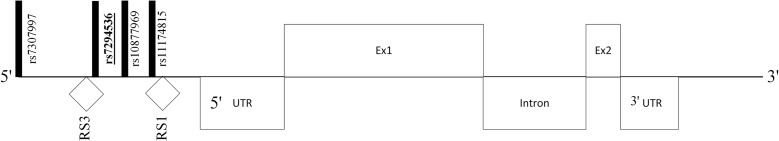
Position of commonly studied SNPs and their relation to exons, introns, and microsatellites (RS1 and RS3) of the arginine-vasopressin 1A receptor gene (AVPR1a) gene. SNPs in bold and underlined were found to be associated with social cognition deficits.